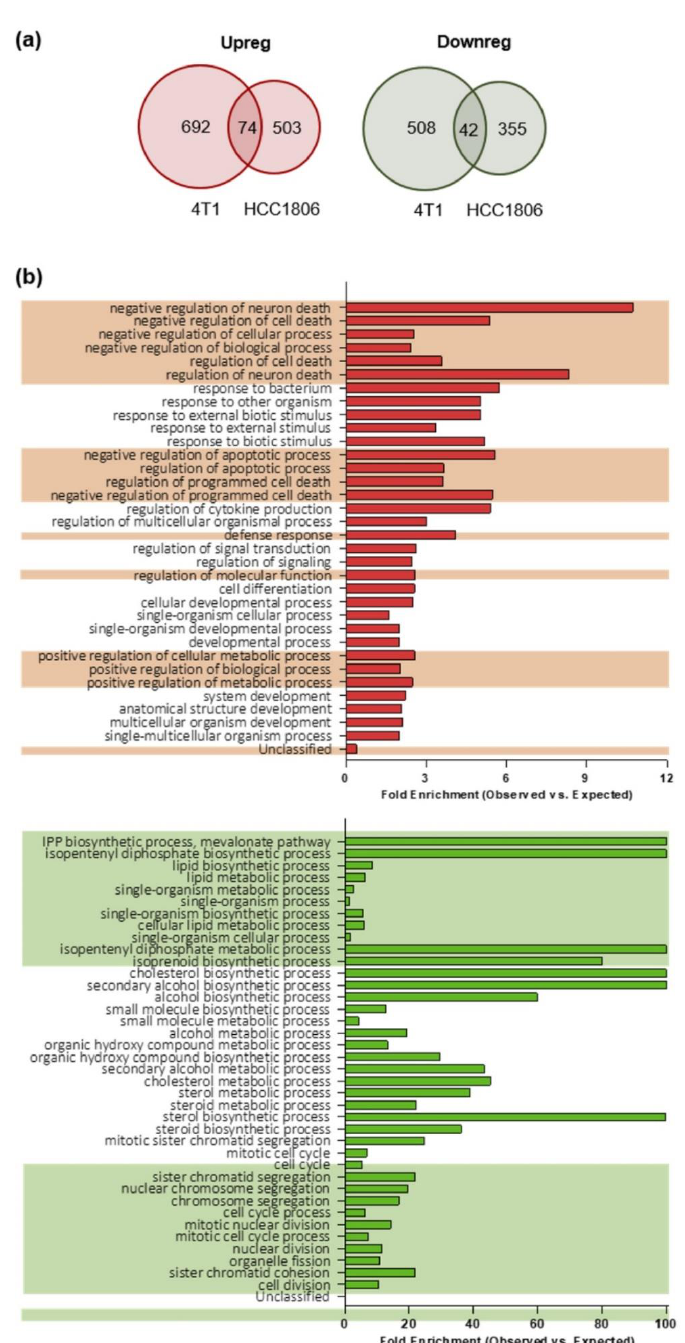
Figure 2. Gene expression profiling and gene ontology (GO) biological processes of epithelial and tumorsphere-derived cells. ( a ) Venn-diagrams representing the number of up-regulated (Upreg; red) or down-regulated (Downreg; green) genes shared between 4T1 and HCC1806 cell lines. ( b ) Histograms representing the distribution of the genes according to their biological function. The reported classes are GO biological processes. In red the analysis of the 4T1 and HCC1806 commonly up-regulated transcripts while in green that of the down-regulated ones. The bars represent the ratio between the number of genes observed for a given biological process (Observed) versus the number of genes that would be observed by chance (Expected) for that same biological process. The alternating background helps to visualize biological processes that are related, and that can be interpretable as a group rather than individually (obtained by the hierarchic sort function of GO).